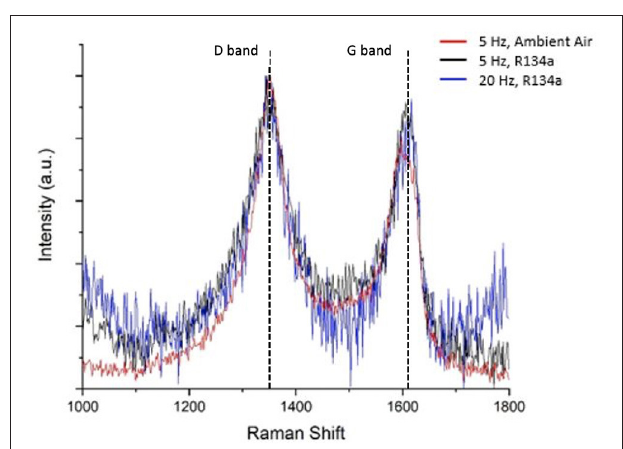
FIGURE 13 | Raman spectra of the